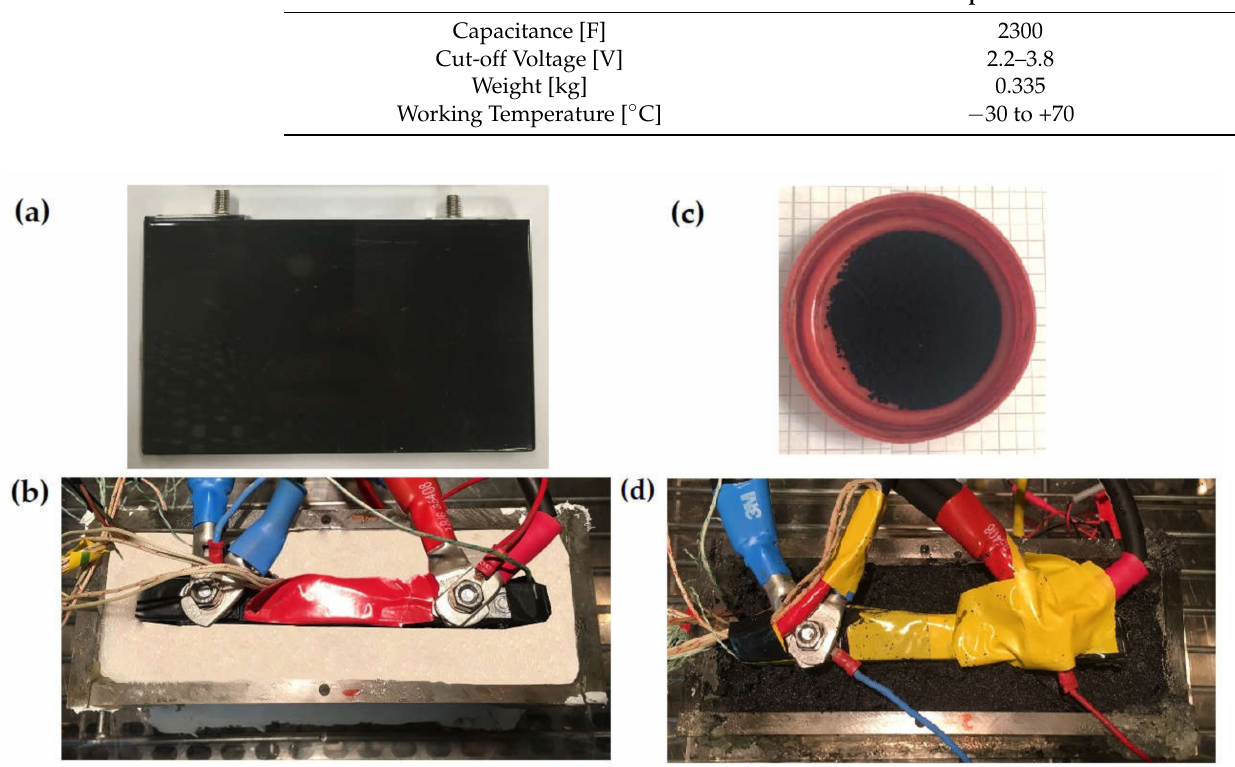
Figure 1. ( a ) The prismatic 2300 F LiC cell; ( b ) the pure PCM TMS poured into the PVC container around the cell; ( c ) pure graphite (4% of the total weight); ( d ) the composite PCM/G TMS poured into the PVC container around the